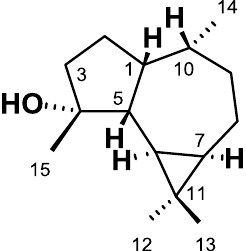
Figure 1. Chemical structure of compound 1 . Table 1. Nuclear Magnetic Resonance data for compound 1 (500 MHz for 1 H and 125 MHz for 13 C in CDCl 3 ). C C δ